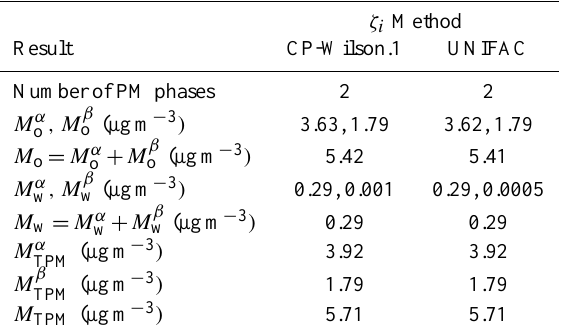
Table 6. Comparison of predictions for the performance evaluation (PE) case by the approach using the CP-Wilson.1 method and the UNIFAC method ( T =298K,